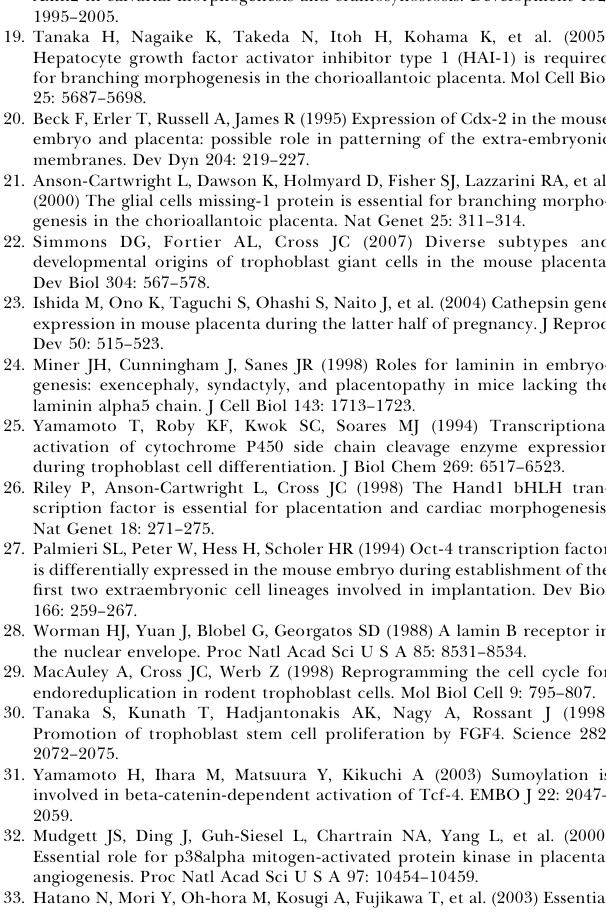
Figure S3. Development of the SENP2 þ / þ and SENP2 –/– TS Cell Lines The TS cell lines were derived from blastocysts isolated at E3.5. Immunostaining analyses of Oct4 (first row) and Cdx2 (second row) were performed on SENP2 þ / þ ES (first column), SENP2 þ / þ TS (second column), and SENP2 –/– TS (third column) cells. Cells were counter- stained by DAPI (third row). Scale bar, 50 l m. Found at doi:10.1371/journal.pbio.0060310.sg003 (1.73 MB